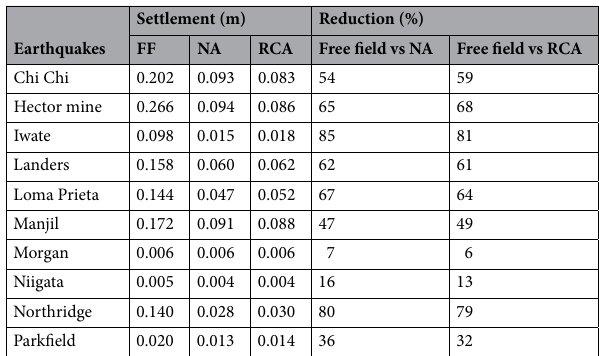
Table 10. The rates of liquefaction-induced settlement reductions for all models.